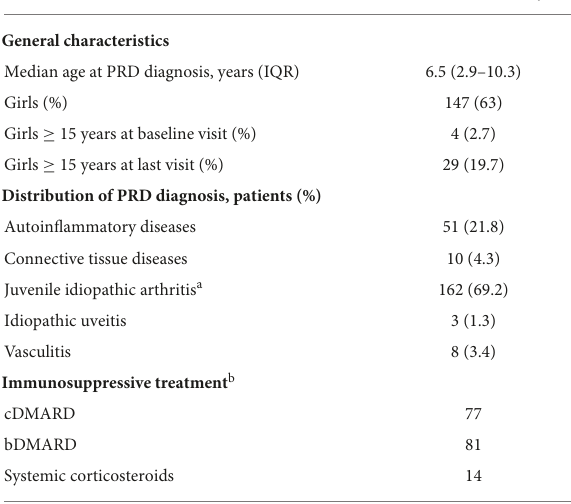
TABLE 2 Characteristics of the study